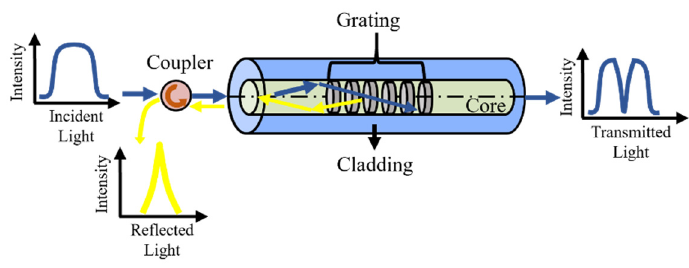
Figure 3. Principle of FBG sensor.